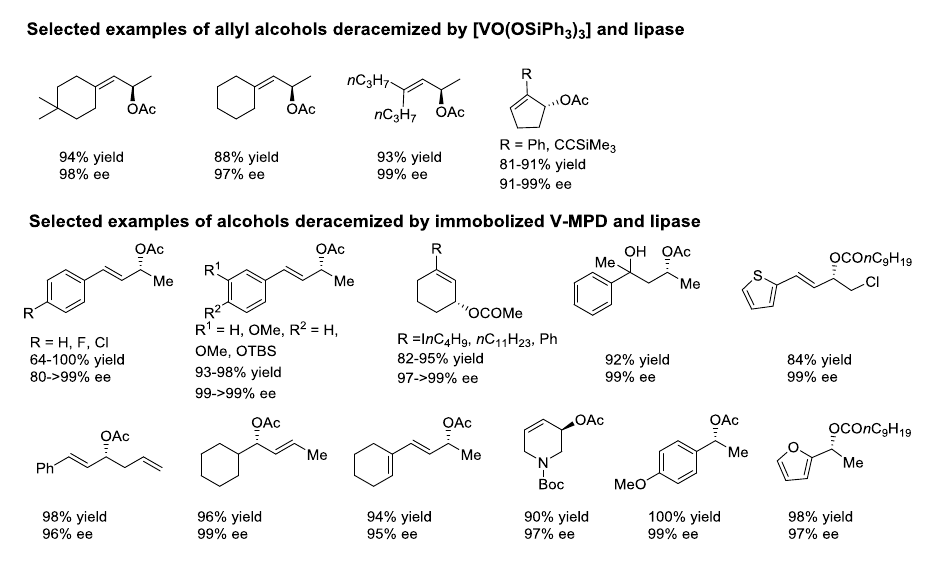
Scheme 2. Scope of DKR systems involving vanadium complexes and various enzymes.